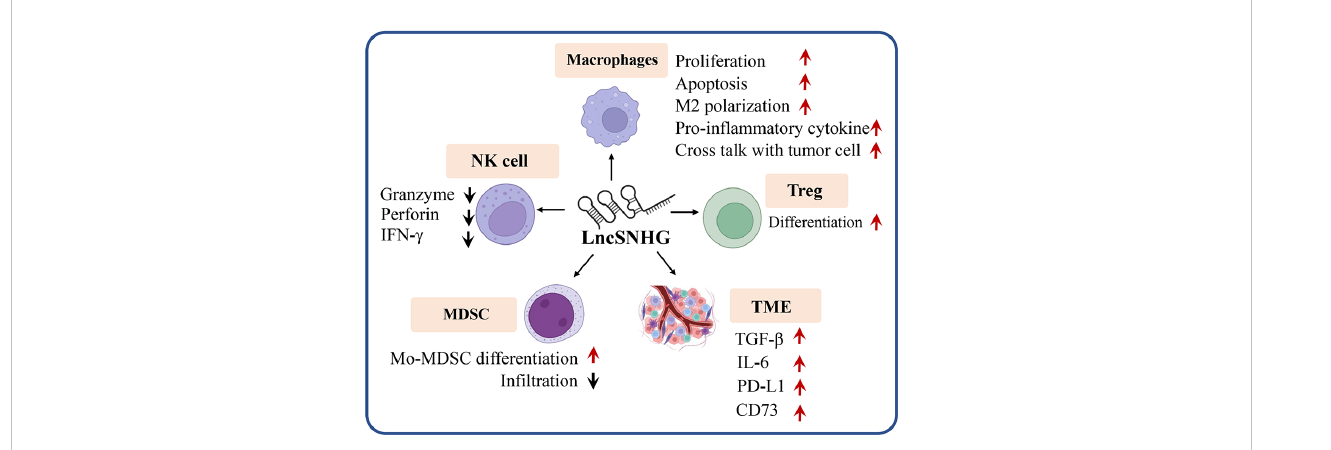
FIGURE 4 LncRNA are able to regulate a variety of immune cells (e.g. Treg, macrophages, MDSC, NK cells), immune checkpoints (e.g. PD-L1, CD73) and cytokines (e.g. TGF, IL-6) to in fl uence tumor immunity. Red arrow, upregulation, black arrow, down